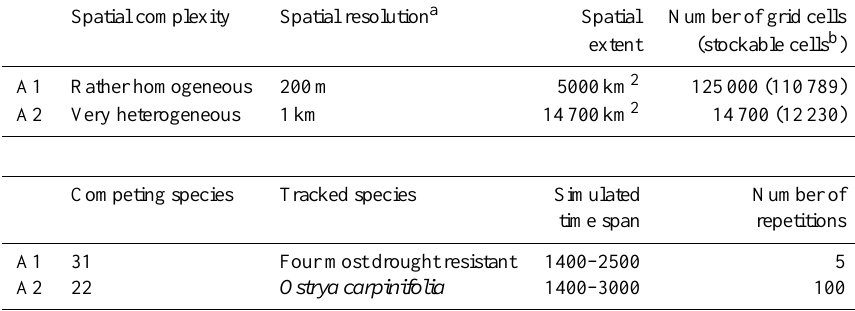
Table 1. Main characteristics of the two application scenarios A1 and A2. Scenario A1 stems from a study with a preliminary TreeMig-2L version (Nabel and Lischke, 2013), scenario A2 from a study on the influence of interannual bioclimate variability on the simulated migration of Ostrya carpinifolia (Nabel et al., 2013). For an in-depth description of the scenarios see Supplement Sect. S2. Spatial complexity